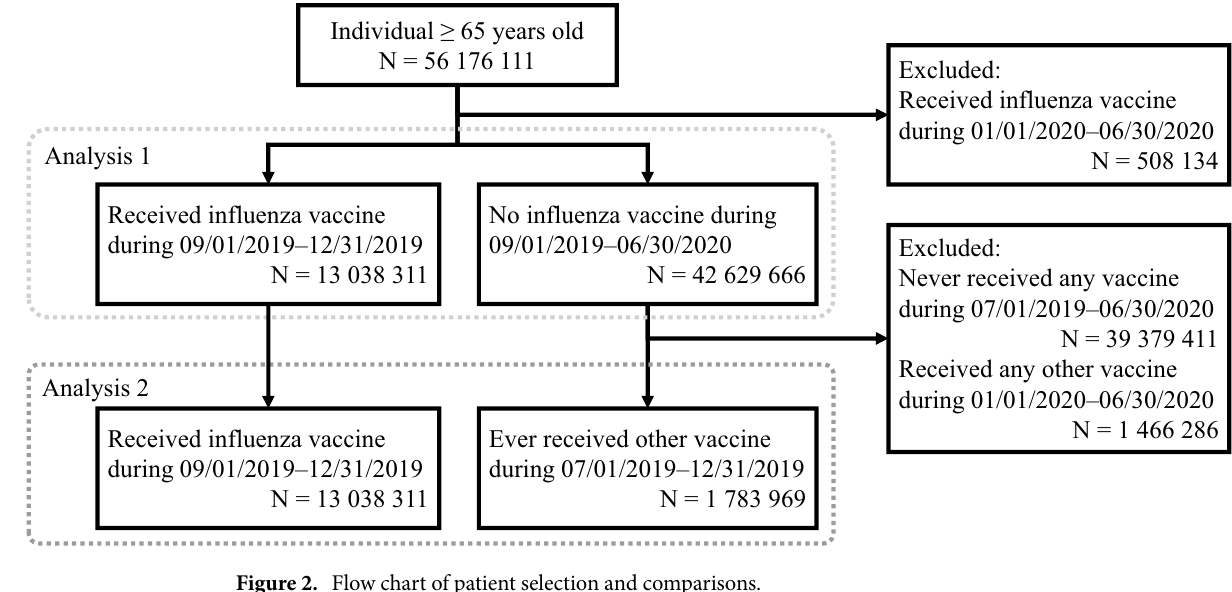
Figure 2. Flow chart of patient selection and